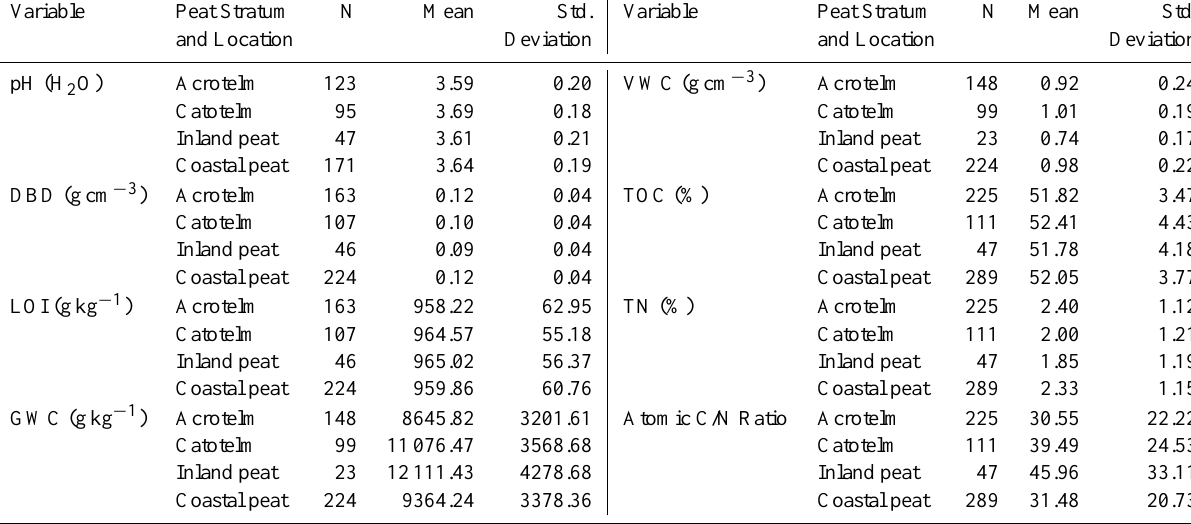
Table 6. Means of Research Variables according to Acrotelm versus Catotelm, and Inland and Coastal Peats. Variable